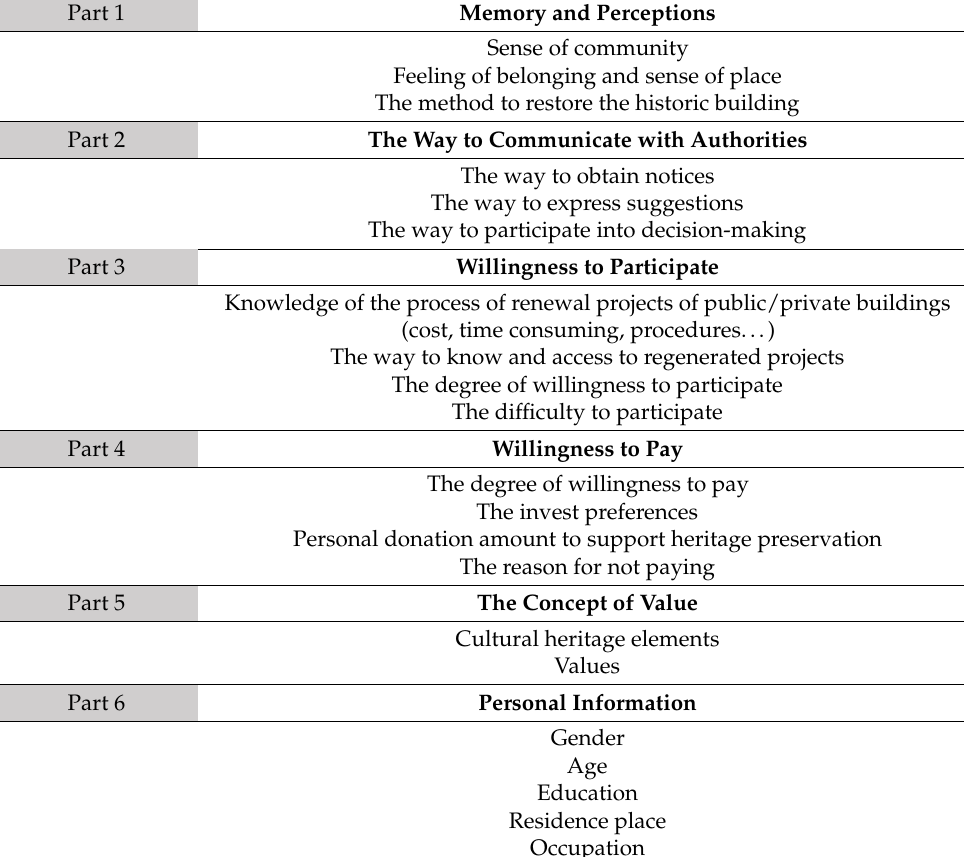
Table 5. The setup and main components of the questionnaire (made by